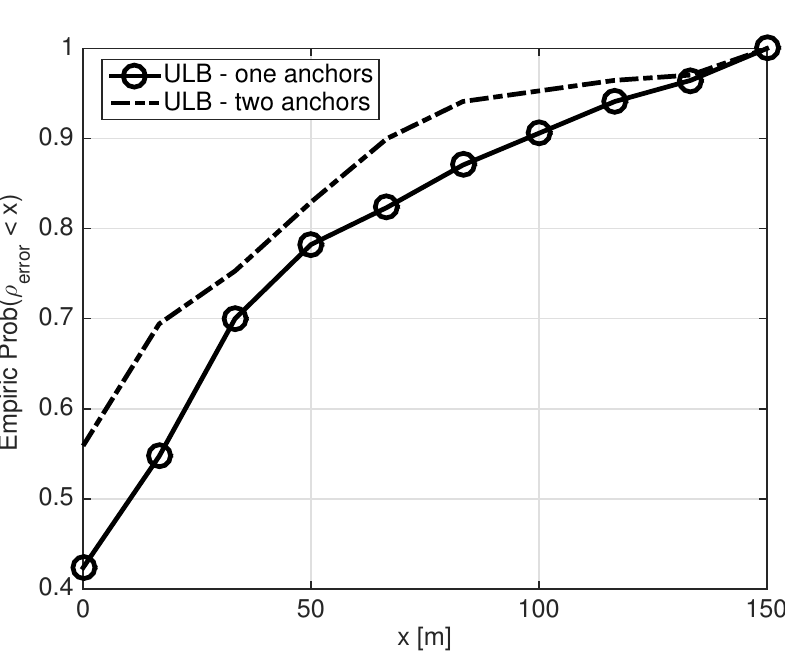
Figure 6. Empirical CDF of ρ error . Set A holds one and two nodes. F in (5a) is defined according to the ‘Summation’ approach.